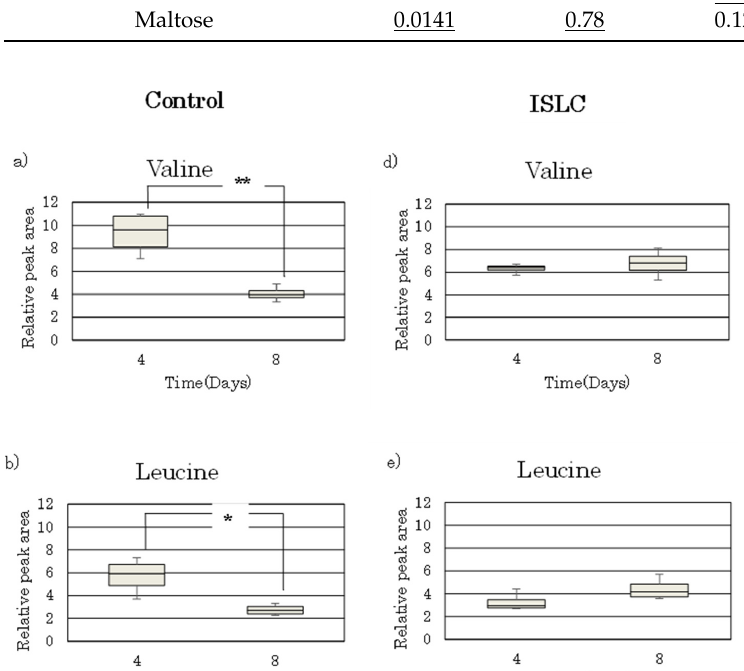
Figure 2. Comparison of BCAAs in adipocytes for 4 and 8 days after di ff erentiation. We performed the metabolome analysis for adipocytes of 2 di ff erent time points (day 4 and 8 of adipogenesis). Metabolite relative peak areas are shown as box plots. Alteration pa tt erns of BCAAs are shown for control cells ( a – c ) and cells treated with ISLCs ( d – f ). p values were calculated according to the Student’s t -test; * p < 0.05, ** p < 0.01 (n = 4). 3.3. Analysis of BCAAs in Cell Culture Medium The BCAAs in the medium of the control and ISLCs-treated cells at days 0, 4, and 8 after di ff erentiation were analyzed with high-performance liquid chromatography, and the results are shown in Figure 3. In both the control (Figure 3a,b,c) and ISLCs-treated cells (Figure 3d,e,f), the BCAAs levels in the medium were high on day 0 and decreased signi fi cantly at day 4 after di ff erentiation. The values at day 8 were almost same as at day 4.